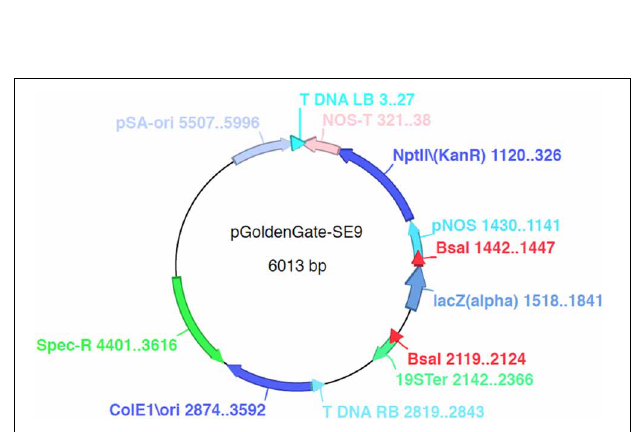
FIGURE A2 | pGoldenGate-SE9 map.